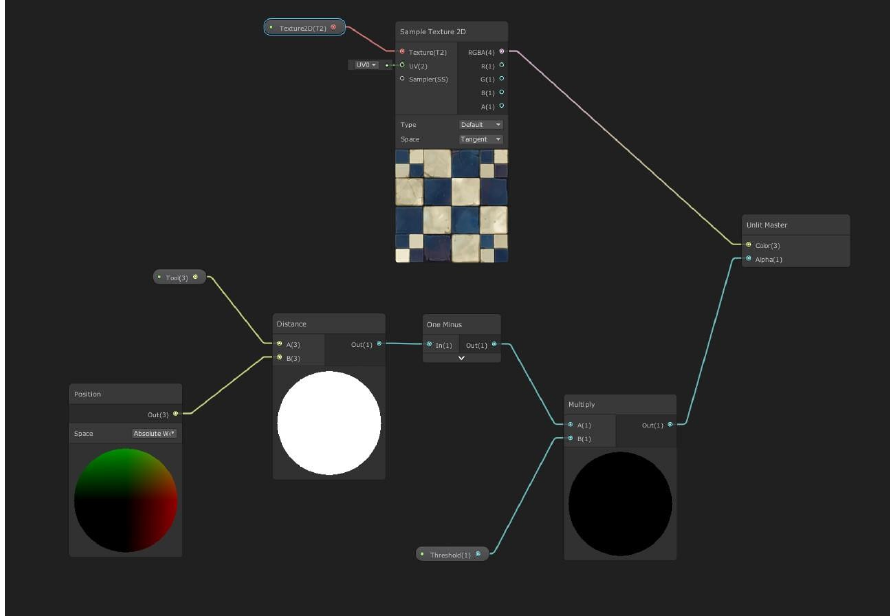
Figure 8. Material shader designed for controlling the visibility of the 3D and 2D boundaries depending on the proximity of the WR end-effector and STR tool,